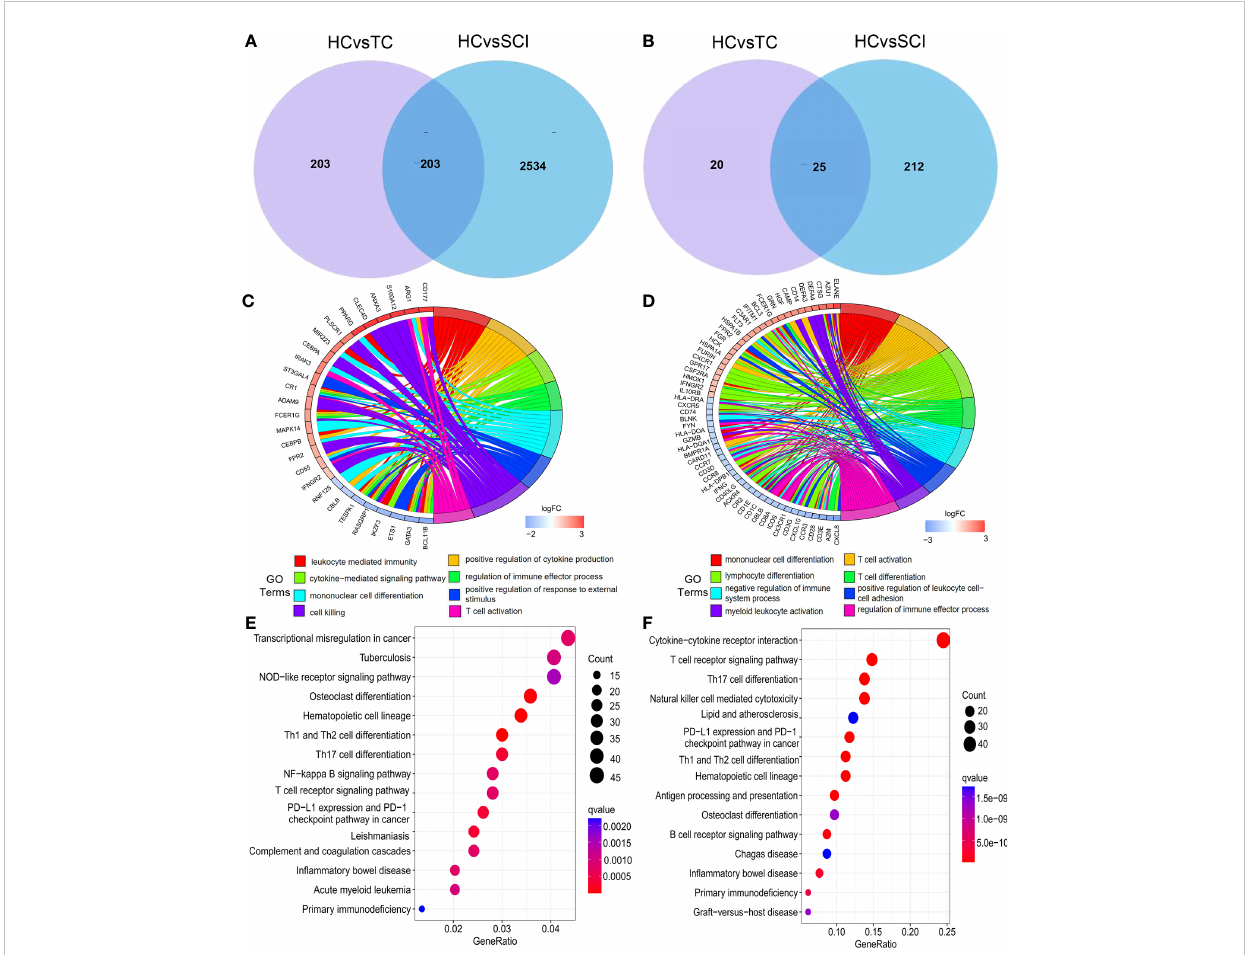
FIGURE 2 DEGs and their enrichment analysis. (A) Venn diagram of DEGs between the TC group and HC group and DEGs between the SCI group and HC group. (B) Venn diagram of DEIGs between the TC group and HC group and DEIGs between the SCI group and HC group. (C) GO functional analysis of DEGs between the SCI group and HC group. (D) GO functional analysis of DEIGs between the SCI group and HC group. (E) KEGG enrichment analysis of DEGs between the SCI group and HC group. (F) KEGG enrichment analysis of DEIGs between the SCI group and HC group. SCI, spinal cord injury; HC, healthy uninjured control; TC, trauma controls with noncentral nervous system injury; DEGs, differentially expressed genes; DEIGs, differentially expressed immune-related genes; GO, Gene Ontology; KEGG, Kyoto Encyclopedia of Genes and